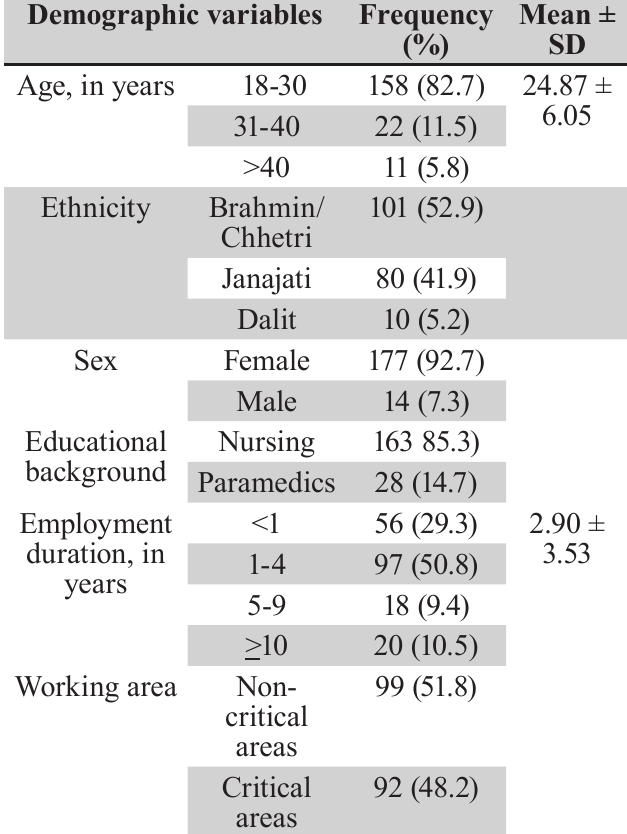
participants (N=191) Demographic variables